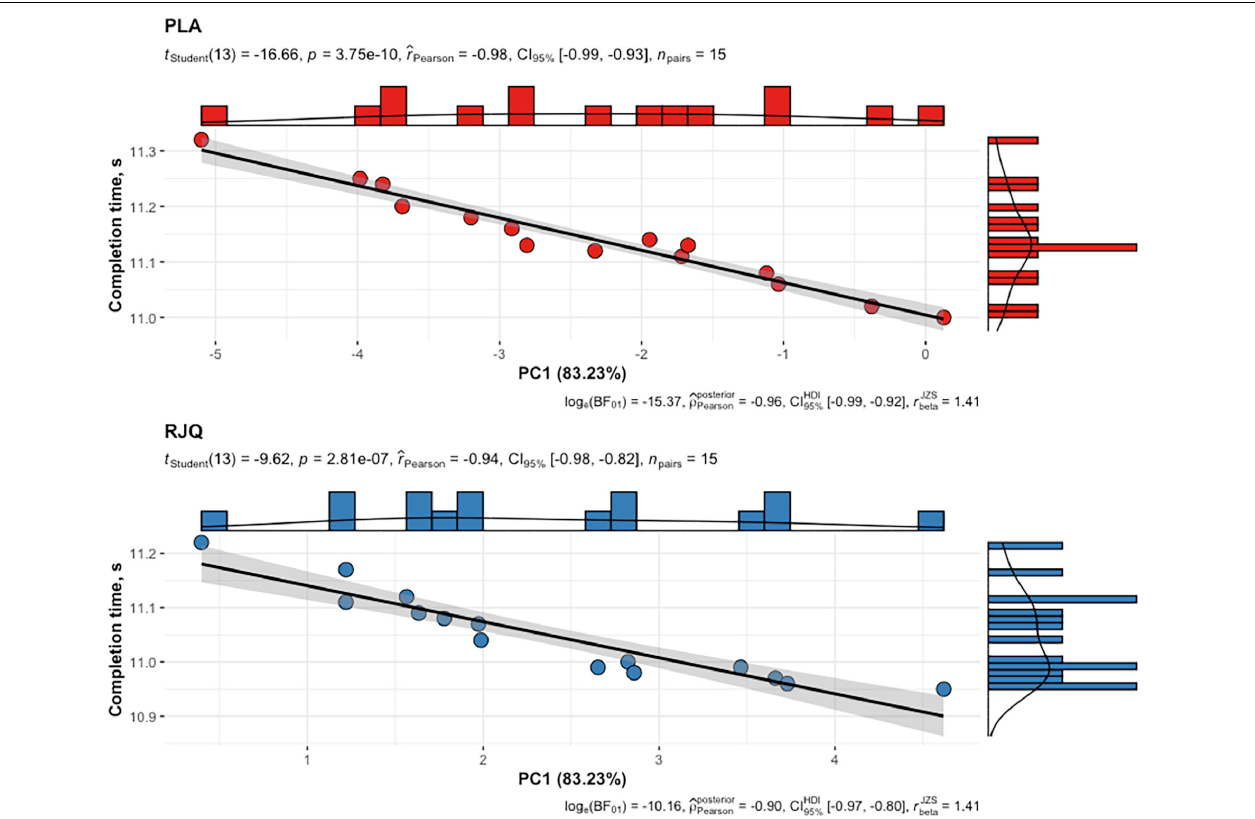
FIGURE 4 | Scattergram of PC1 values and time taken by athletes to complete HIIE in both intervention groups. n = 15 per group. PC1, principal component 1; RJQ, royal jelly plus coenzyme Q10; PLA,